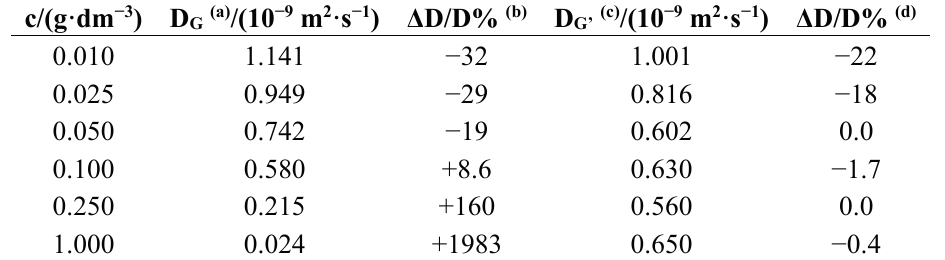
Table 5. Comparison between the measured and theoretical mutual diffusion coefficients, D G and D G’ , of NaHy at T = 25 °C in aqueous solutions at finite concentrations, c